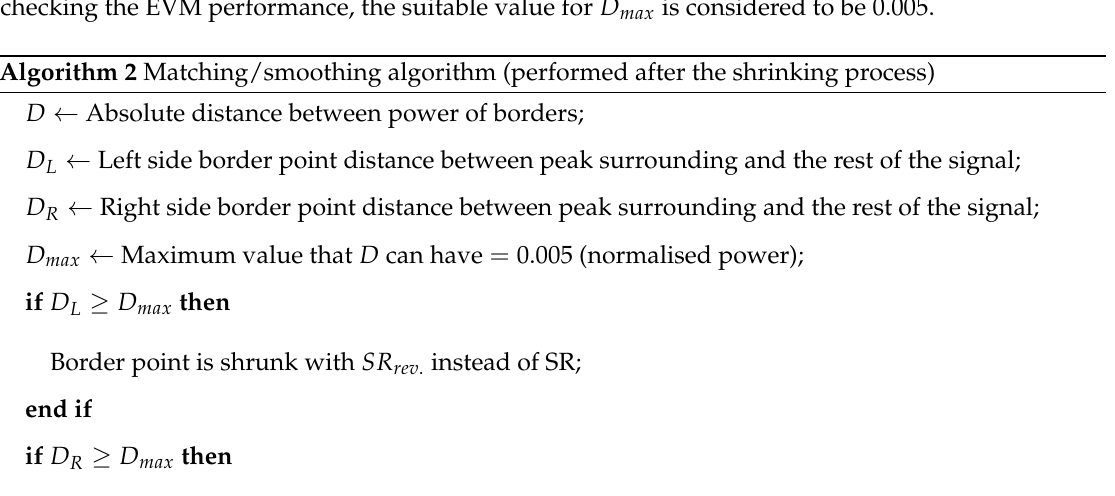
Algorithm 2 Matching/smoothing algorithm (performed after the shrinking